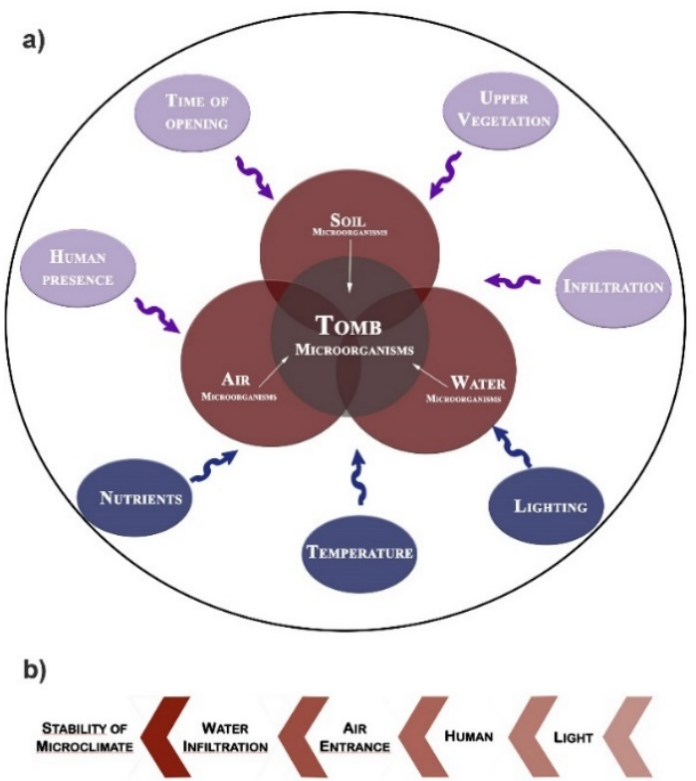
Figure 5. Microorganisms occurring in hypogeal tombs and factors influencing their qualitative and quantitative composition ( a ); main factors affecting the microclimate stability, this last is the main goal to be achieved ( b ). (Original elaboration by the authors).